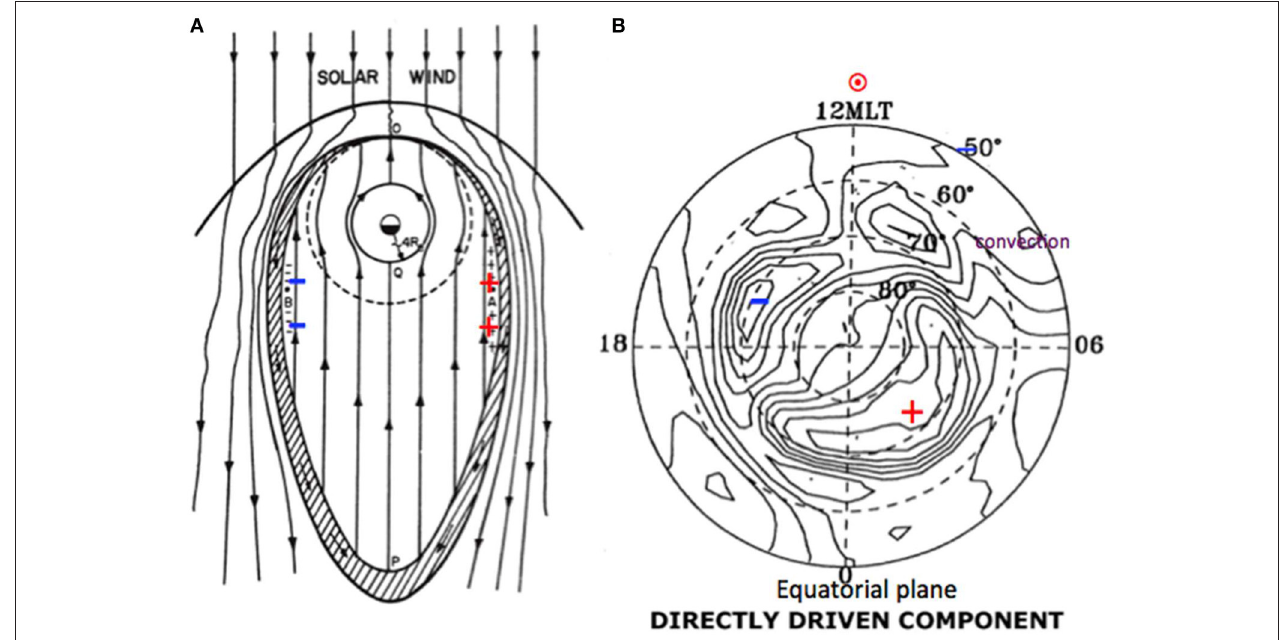
FIGURE 7 | (A) the morning ( + ) and evening (–) boundaries (the terminals of the solar wind-magnetosphere dynamo) of the magnetosphere are connected with auroral oval in the polar ionosphere. The dawn-to-dusk directed electric field causes the earthward flow of plasma on the equatorial plane ( Axford and Hines, 1961). (B) the observed equi-potental contours in the ionosphere ( Sun et al., 2002).